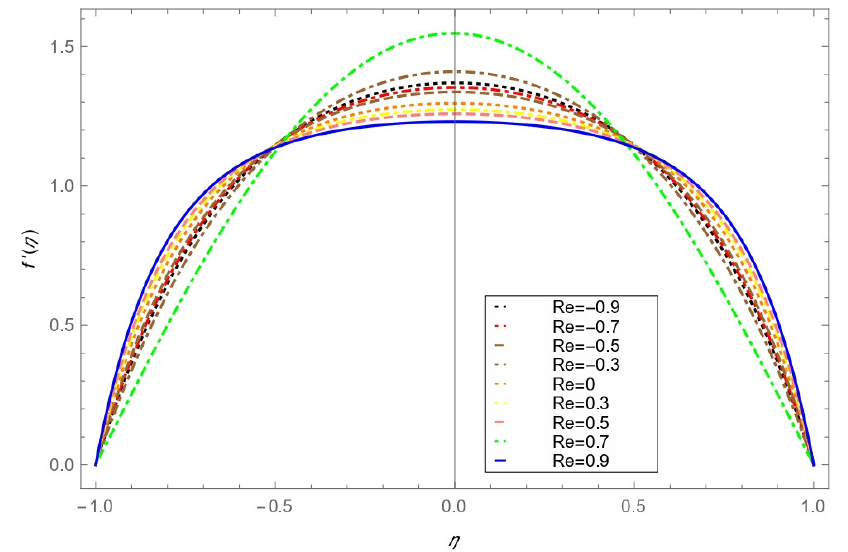
Figure 13. Radial velocity profile effect of the Reynolds number for α = − 2, ϕ 1 = ϕ 2 = 0.02, Pr = 6.2.